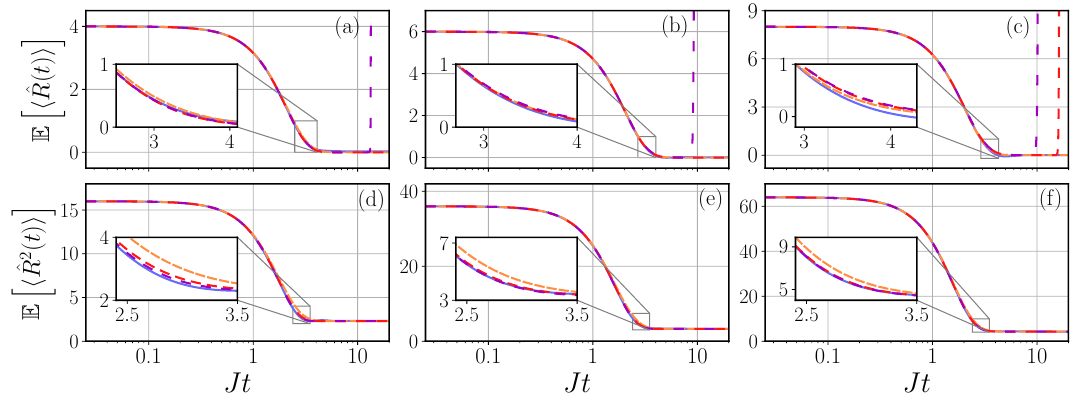
ˆ ˆ Figure 2 . Comparison of disorder-averaged dynamics of R and R 2 obtained using exact diagonal- ization (solid blue curve), and the cumulant expansion truncated at second (dashed orange curve), fourth (dashed red curve), and sixth (dashed purple curve) order. Data is for (a) and (d) N = 8 with 100000 samples, (b) and (e) N = 12 with 3000 samples, (c) and (f) N = 16 with 500 samples, at half filling Q = N/ 2 . For ˆ R 2 , in all cases the addition of an extra cumulant manifestly improves the approximation of the exact dynamics (see insets). The same is true in the case of ˆ R when adding C for N = 8 , 12 , whereas long-time divergences appear when adding C for all considered 4 6 system sizes, and already when adding C for N = 16 . These pathologies are due to an inappro- 4 priate truncation of the cumulant at some system sizes. We also point out that generally (in the time windows preceding divergencies, if present) the variation induced by introducing the fourth cumulant is larger than that due to the sixth cumulant, which suggests quick convergence of the cumulant